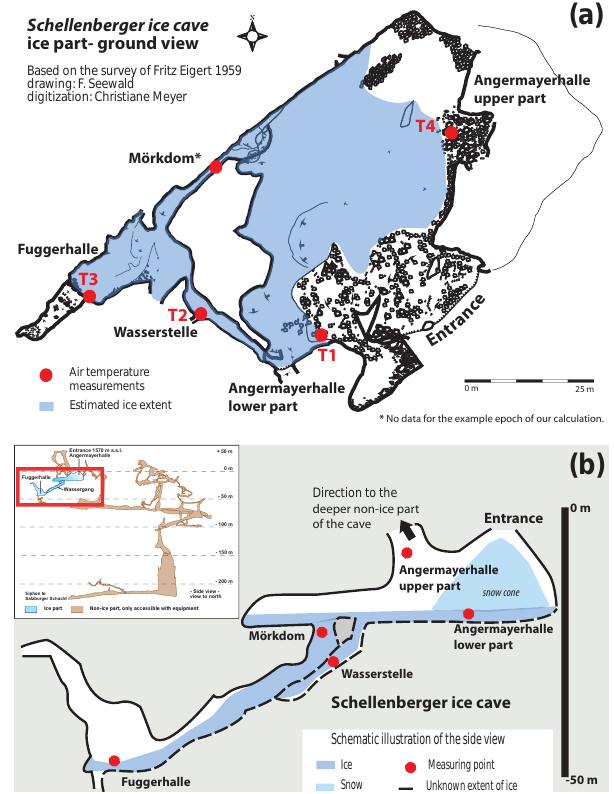
Figure 2. Ground map and side view of Schellenberger Eishöhle with positions of all temperature